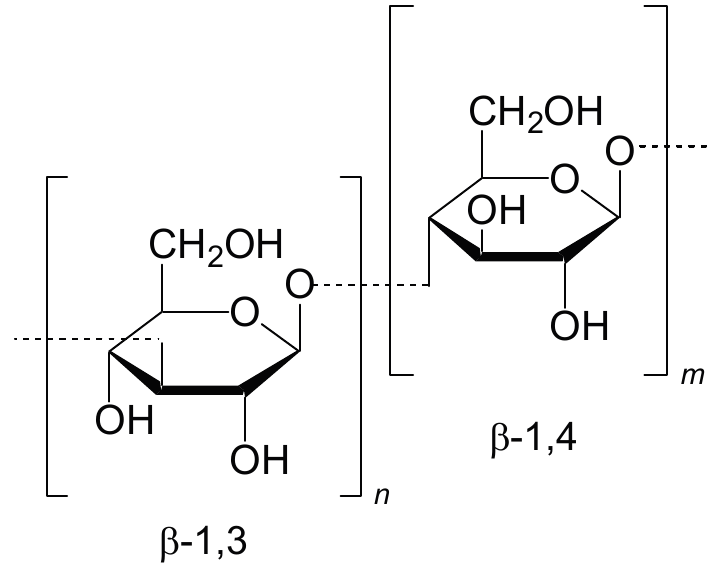
Figure 1. Chemical structure showing the β -1,3 and β -1,4 bonds of β